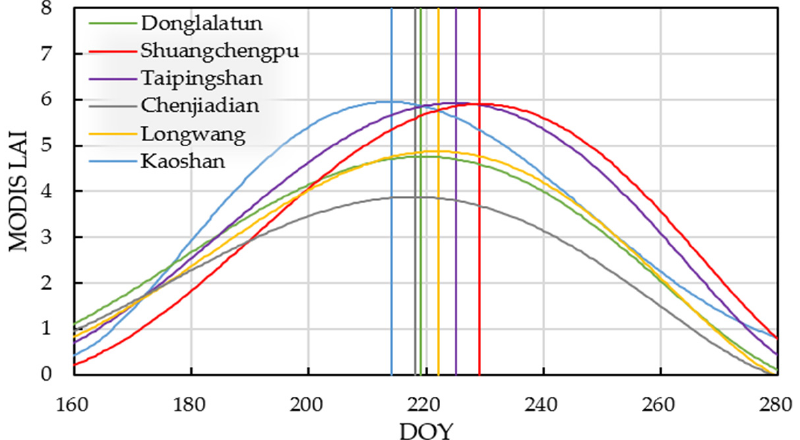
Figure 9. The LAI variation characteristics of the MODIS product in six areas for the entire growing season; the colors of the piecewise lines correspond to the fitted polynomial curves.